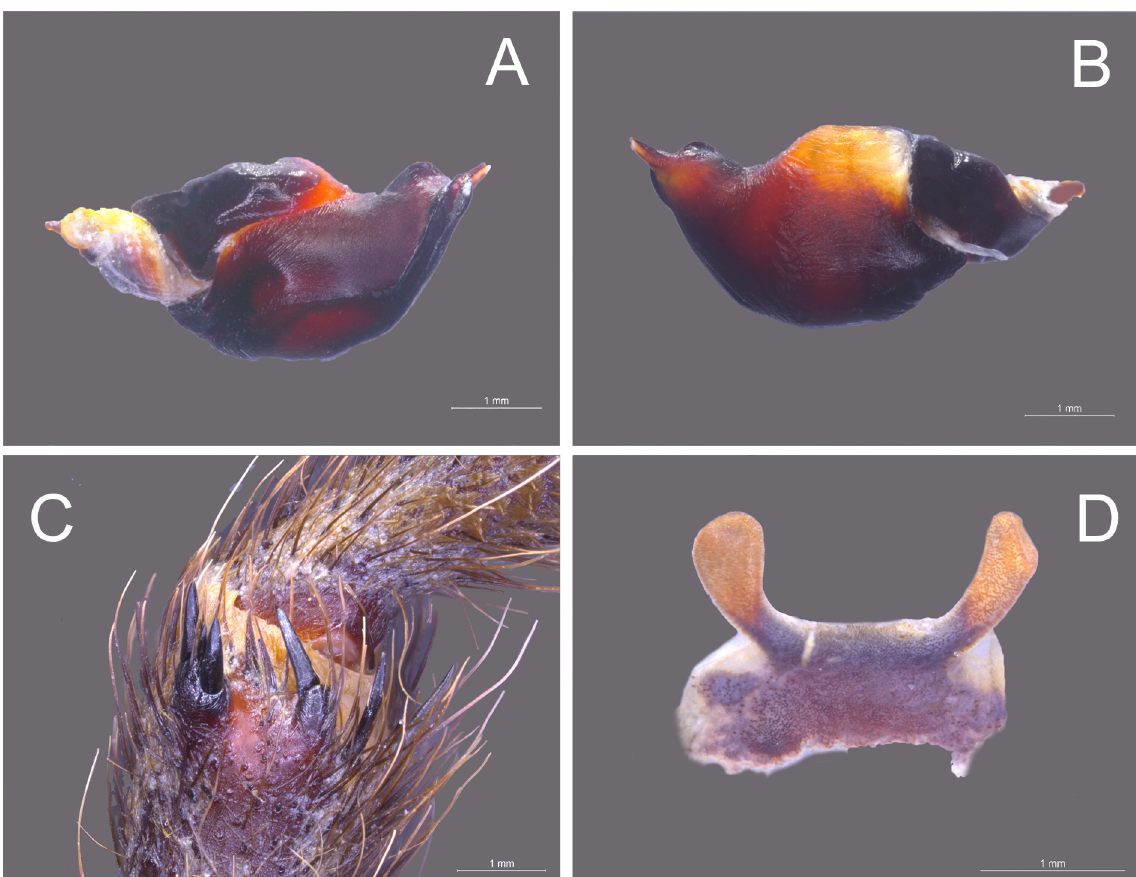
Fig. 21. Umbyquyra belterra gen. et sp. nov. A–C . Holotype, ♂, Flona do Tapajós, Belterra, Pará, Brazil (IBSP 167421). A . Palp, prolateral. B . Retrolateral. C . Tibial apophysis, retrolateral. D . Paratype, ♂, spermathecae, dorsal (IBSP